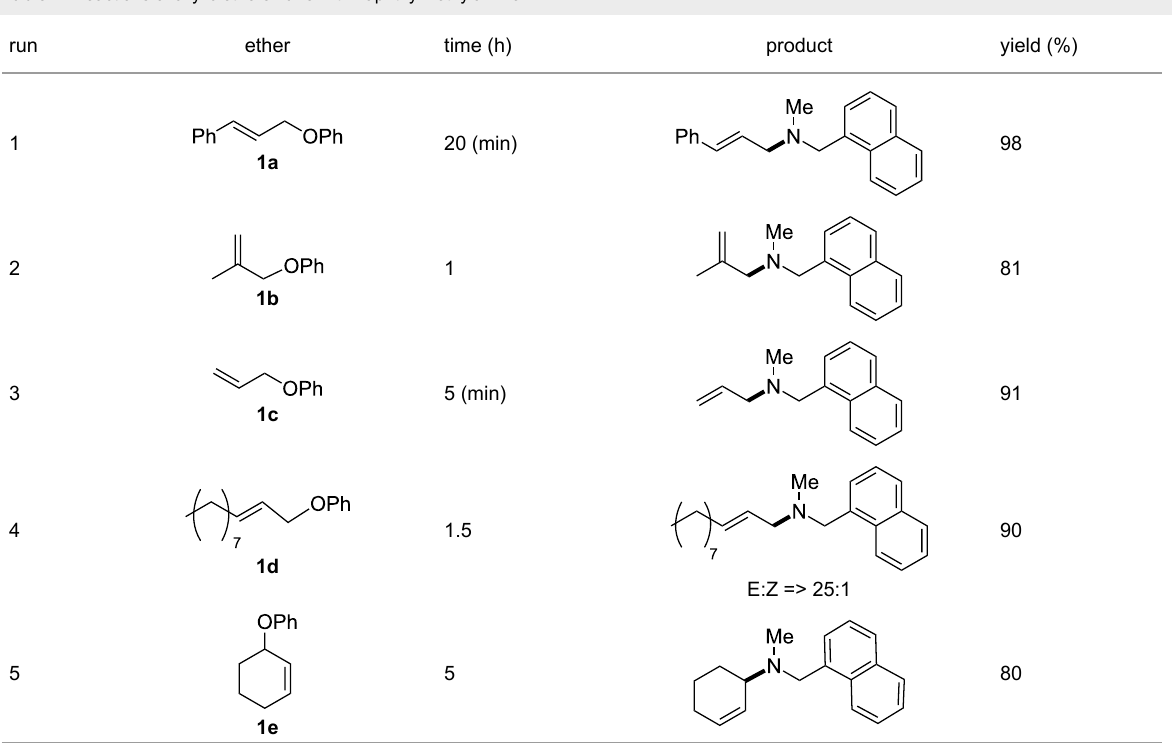
Table 2: Reactions of allylic ethers 1a – e with naphthylmethylamine a